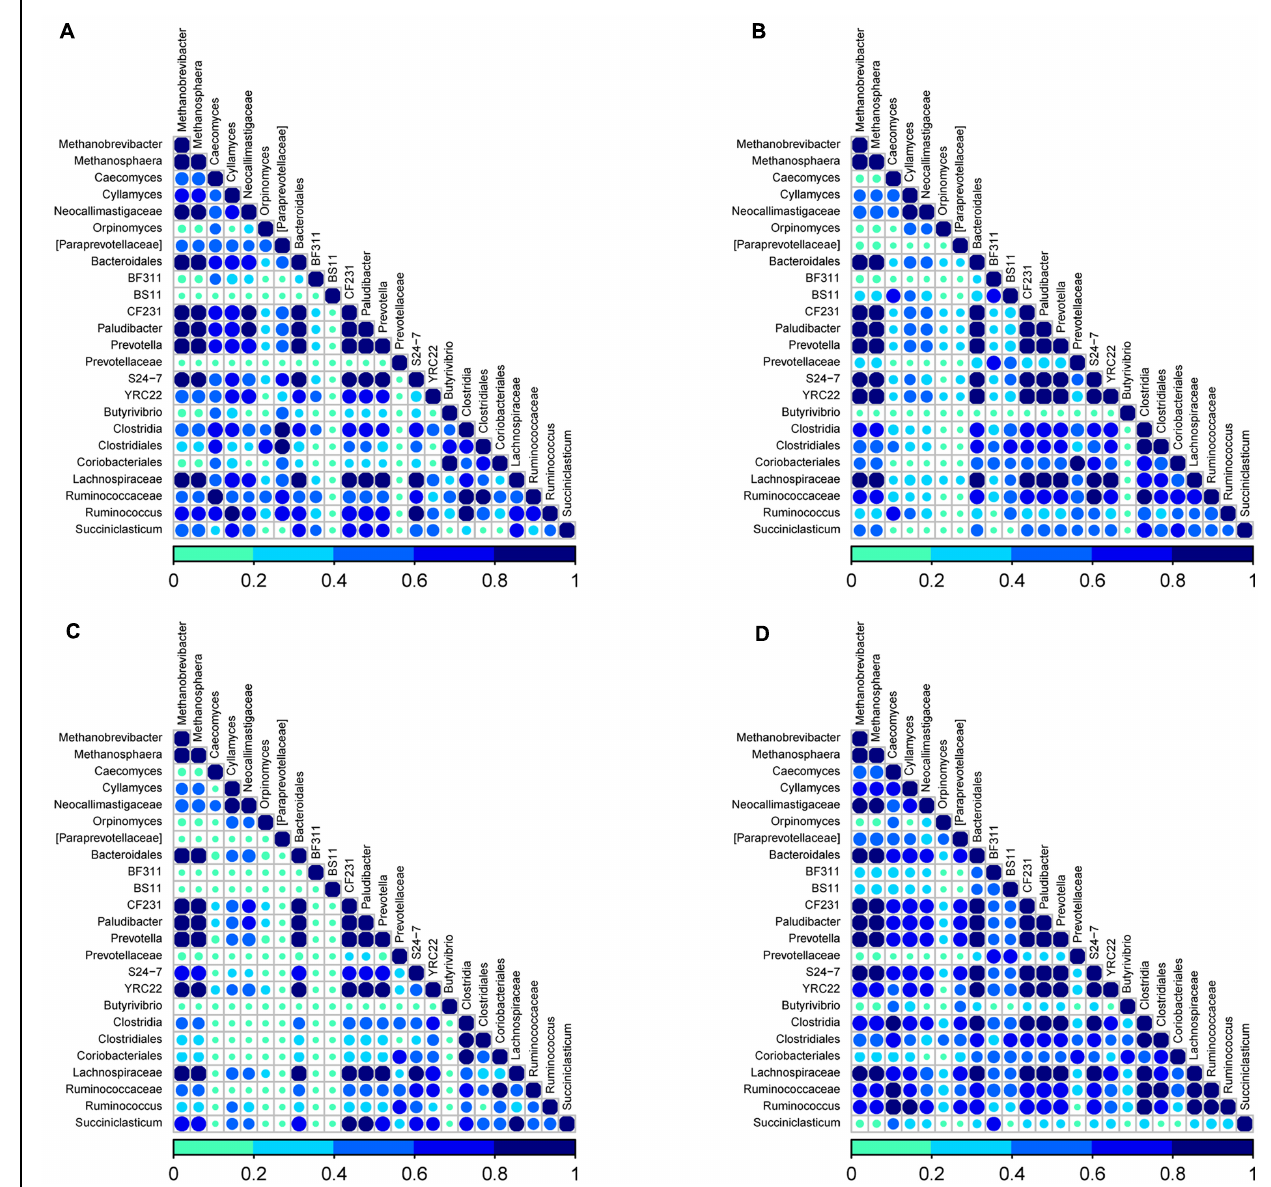
FIGURE 4 | Analysis of co-occurrence among microbial lineages scored using the Dice index (A) diet D1, (B) diet D2, (C) primiparous cows, and (D) multiparous cows. Dice indexes across all genera for bacteria and archaea pairs present at a proportion = 0.01 and for fungi at a